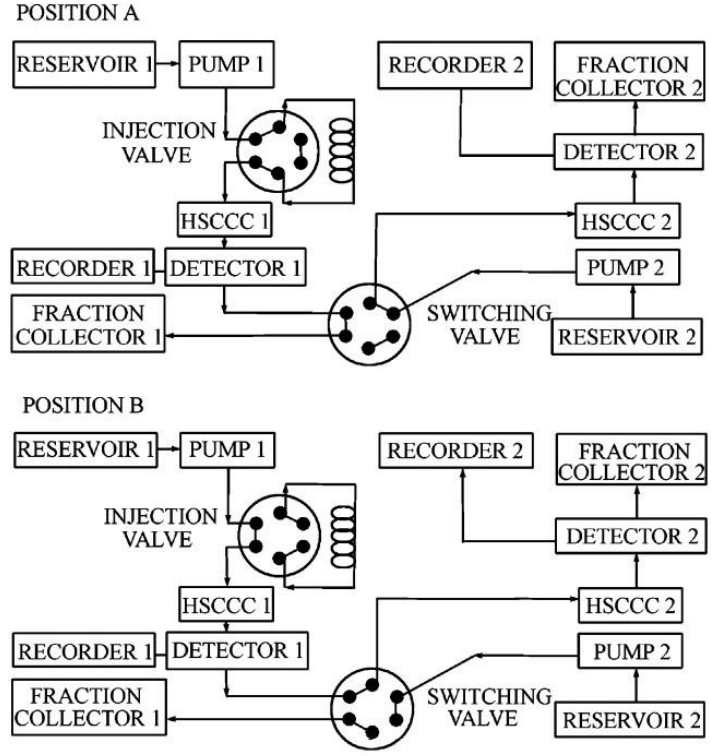
Figure 4. Schematic diagram of the 2D HSCCC system with a six port injection valve and a six port switching valve, the first separation in HSCCC 1 (position A) and the further separation in HSCCC 2 (position B)